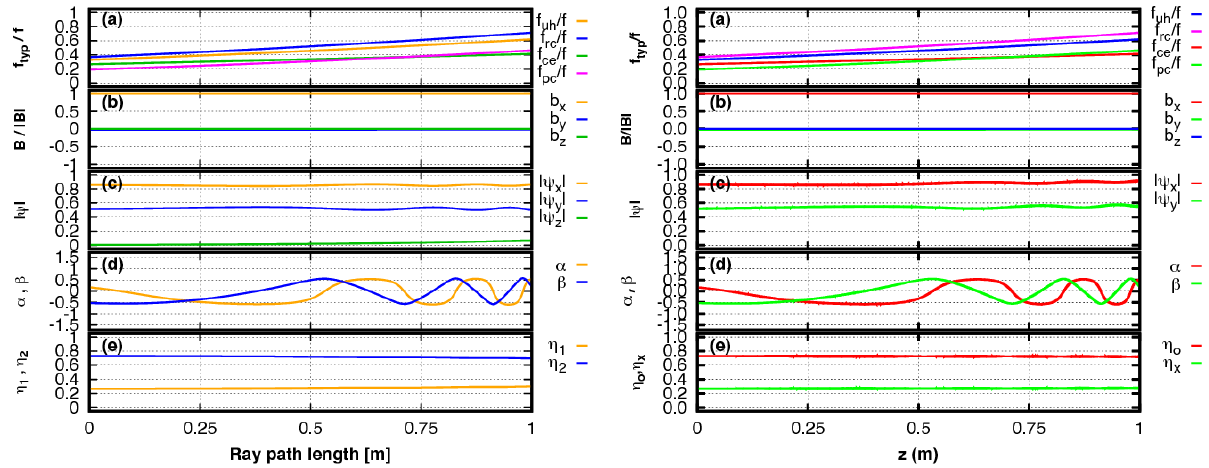
Figure 2. Calculation results of 1DFW in cold plasma slab with a magnetic field shear period (cid:28) s = 1000. (a) - (e) have the same meaning with Fig. 1